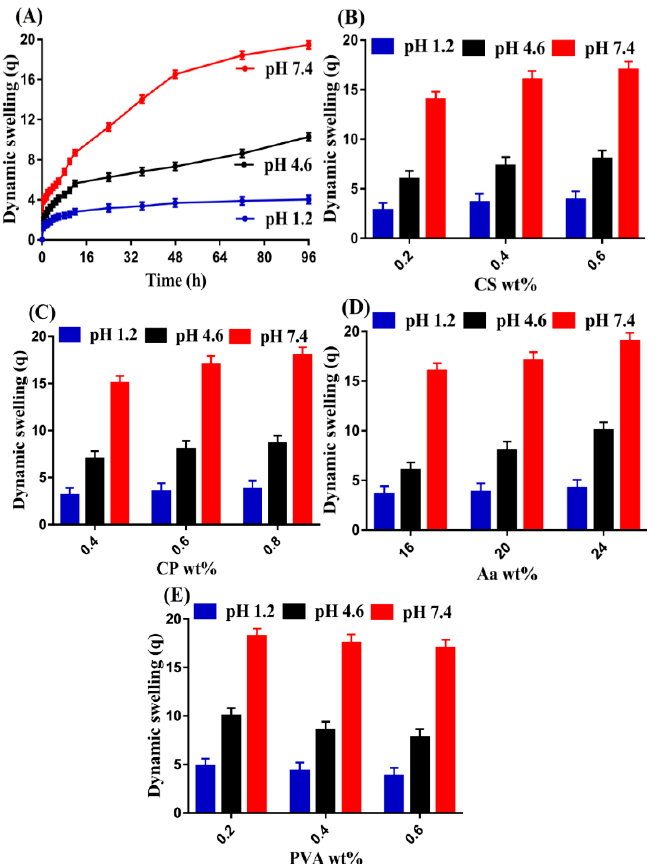
Figure 10. Effect of ( A ) pH, ( B ) CS, ( C ) CP, ( D ) Aa, and ( E ) PVA on dynamic swelling of CS/CP/PVAcPAa hydrogel.